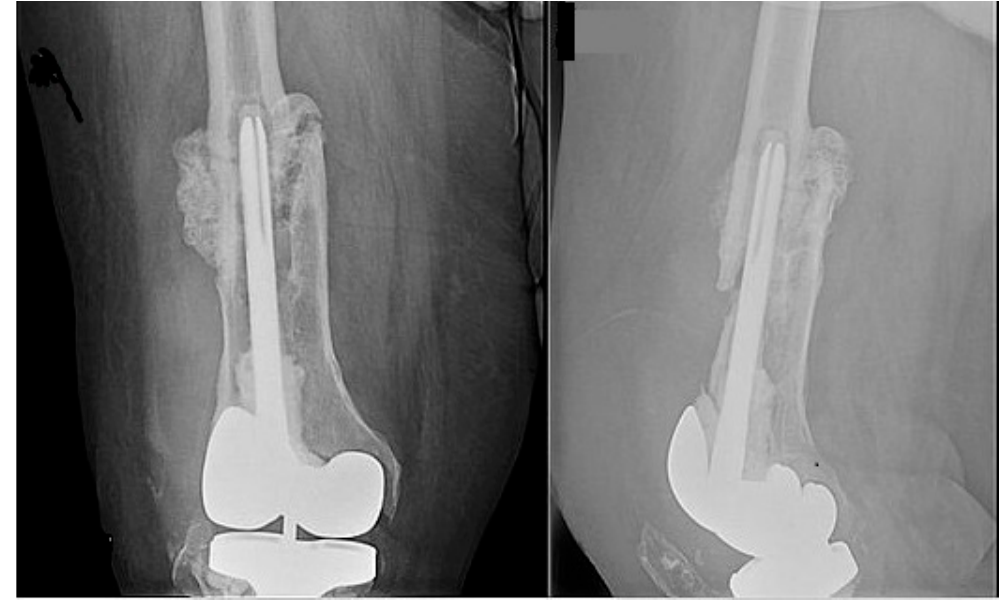
Figure 1. Xray anterior-posterior and lateral views of the right femur showing prior incompletely united distal femoral shaft fracture .